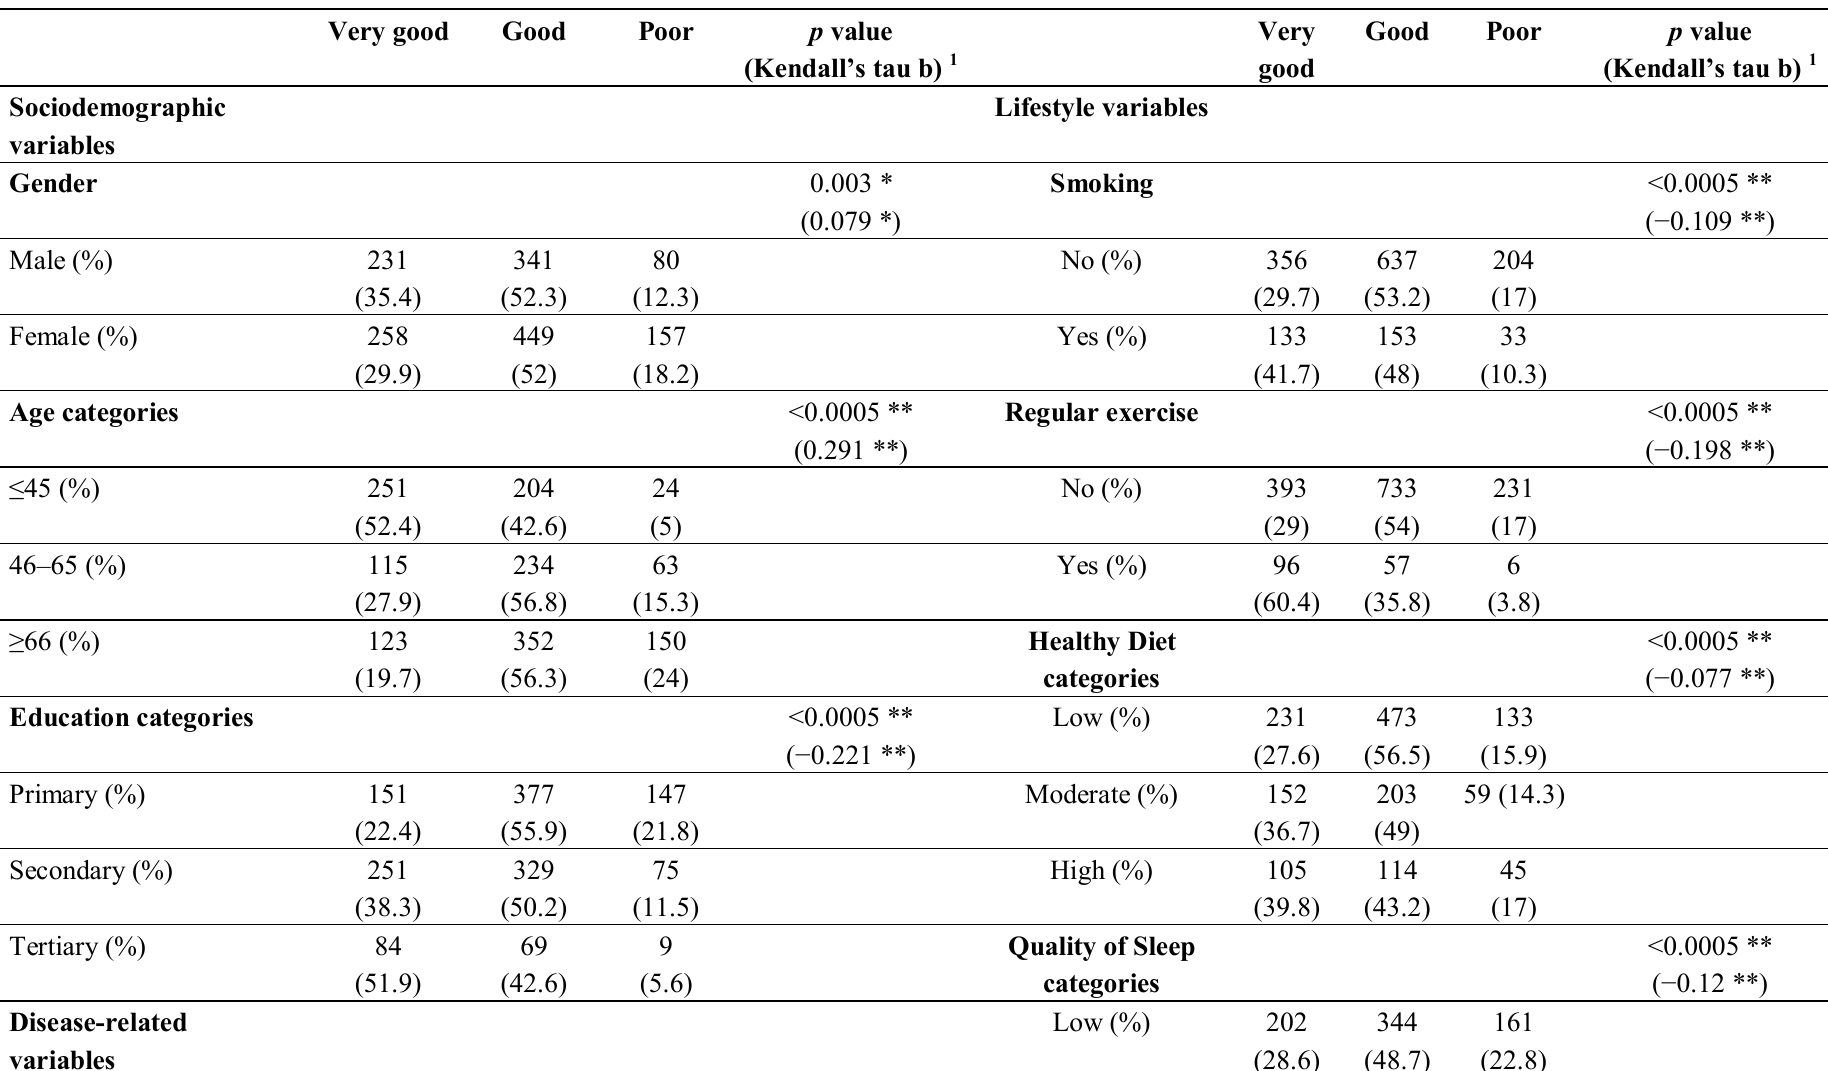
Table 1. Univariate analyses of sociodemographic, disease-related and lifestyle variables with SRH categories (N = 1,519) (chi-square tests). Very good Good Poor p value (Kendall’s tau b) 1